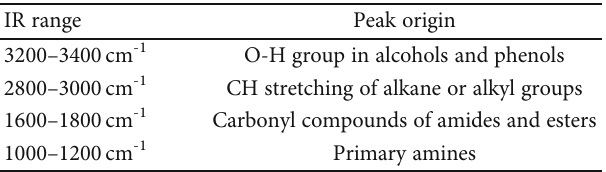
Table 2: FTIR peak ranges and their respective assigned functional groups of compounds.